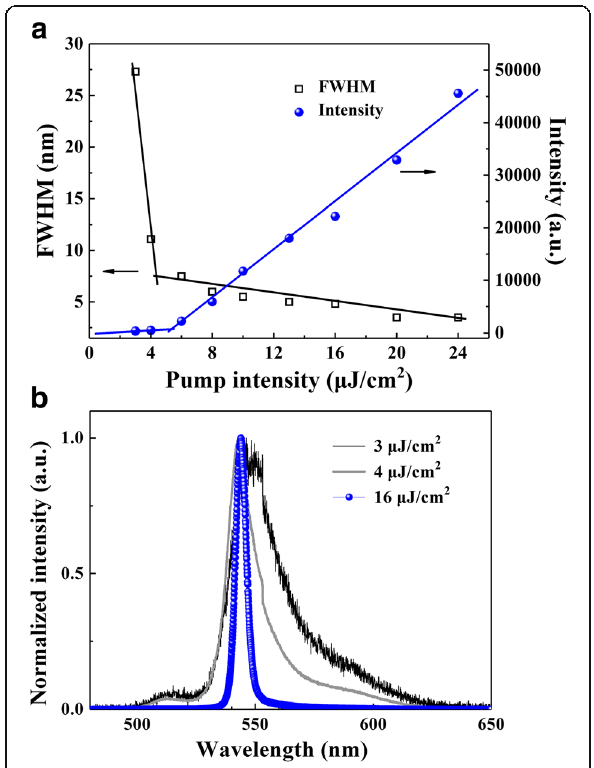
Fig. 2 a Dependence of FWHM (squares) and peak intensity (spheres) of POFP films (135 nm) at various pump intensities. b The evolution of emission spectrum of POFP films (135 nm) with increasing pump intensity